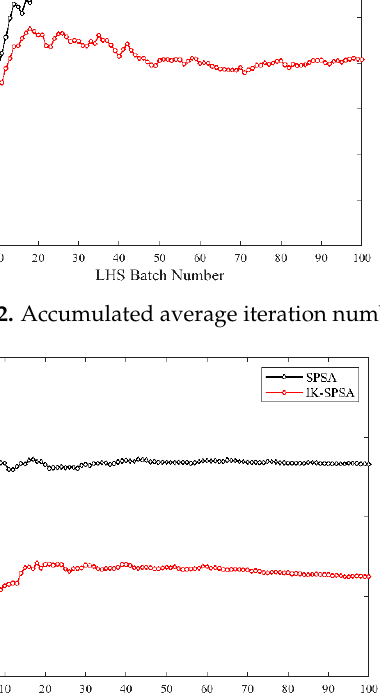
Figure 22. Accumulated average iteration number distribution at different initial points.